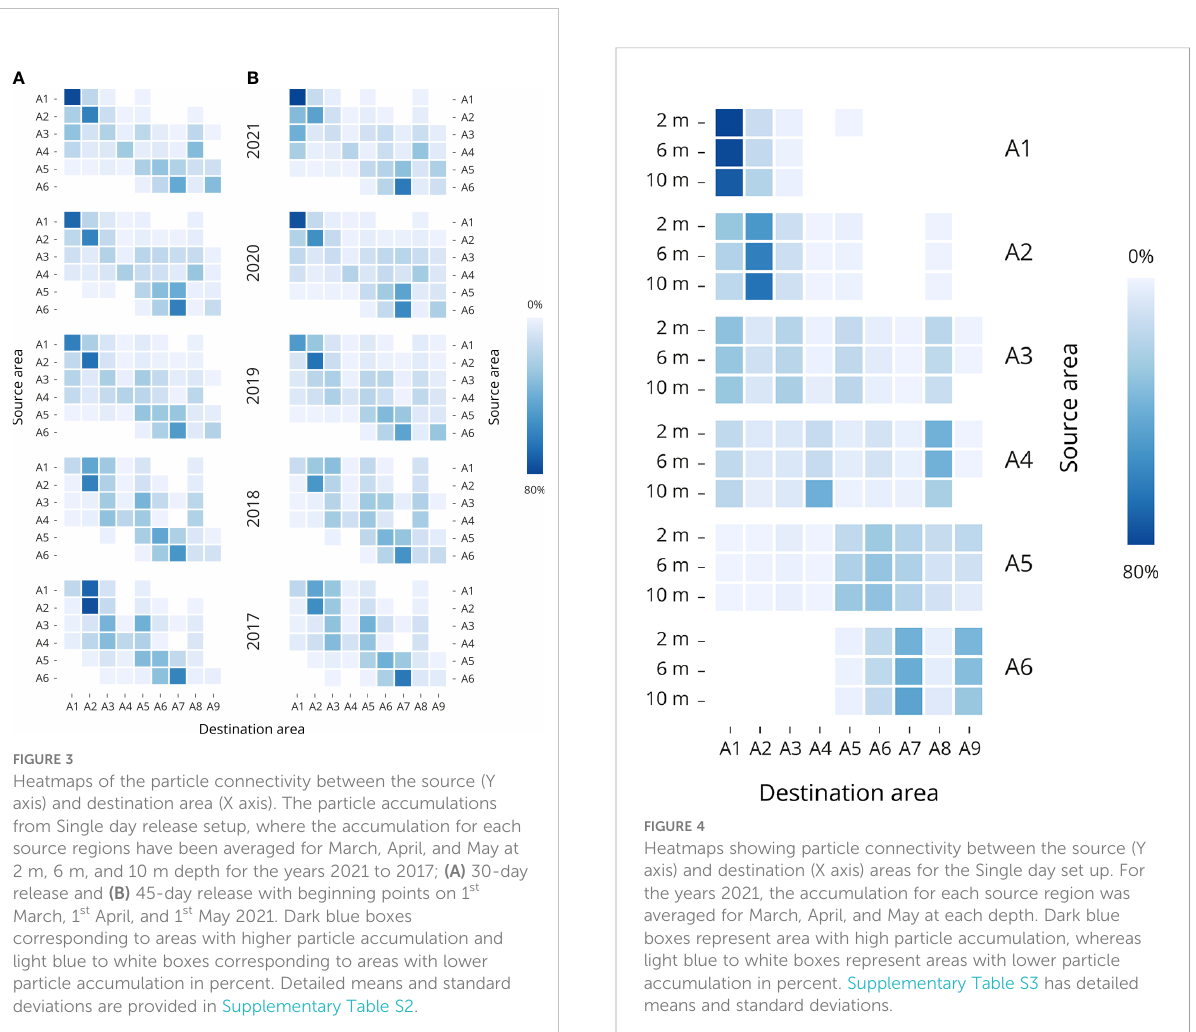
(Figure 3B and Supplementary Table S3), the release of particles from the source points in A1 to A6 show a similar pattern as the one described for the 30-day simulation period. But since the particles have been circulating for 45 days, slightly more dispersion has been observed. However, the re fl ecting higher particle retention values. Details particle dispersal through 2021 for March, April, and May, at 2 m, 6 m and 10 m depth are available in Supplementary Figure S3.